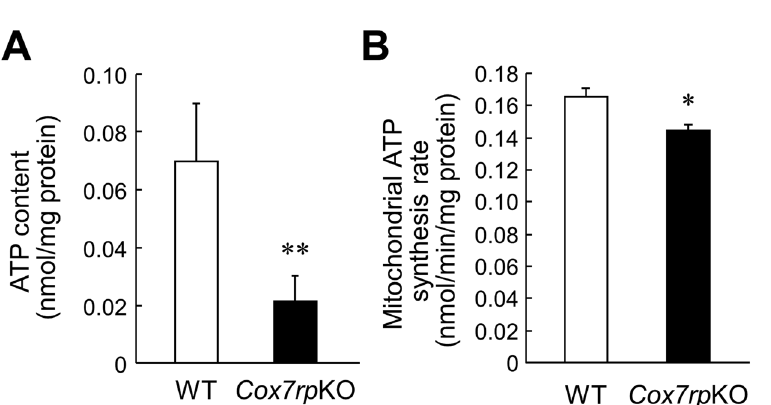
Figure 7. COX7RP deficiency reduces ATP production in hepatic mitochondria. ( A ) Decreased ATP contents in liver of 10-month-old Cox7rp KO mice. Data are presented as means ± SEM ( n = 6). ( B ) ATP synthesis rates in liver of Cox7rp KO and WT mice. Data are presented as means ± SEM ( n = 3). * P < 0.05, ** P < 0.01, using Student’s t